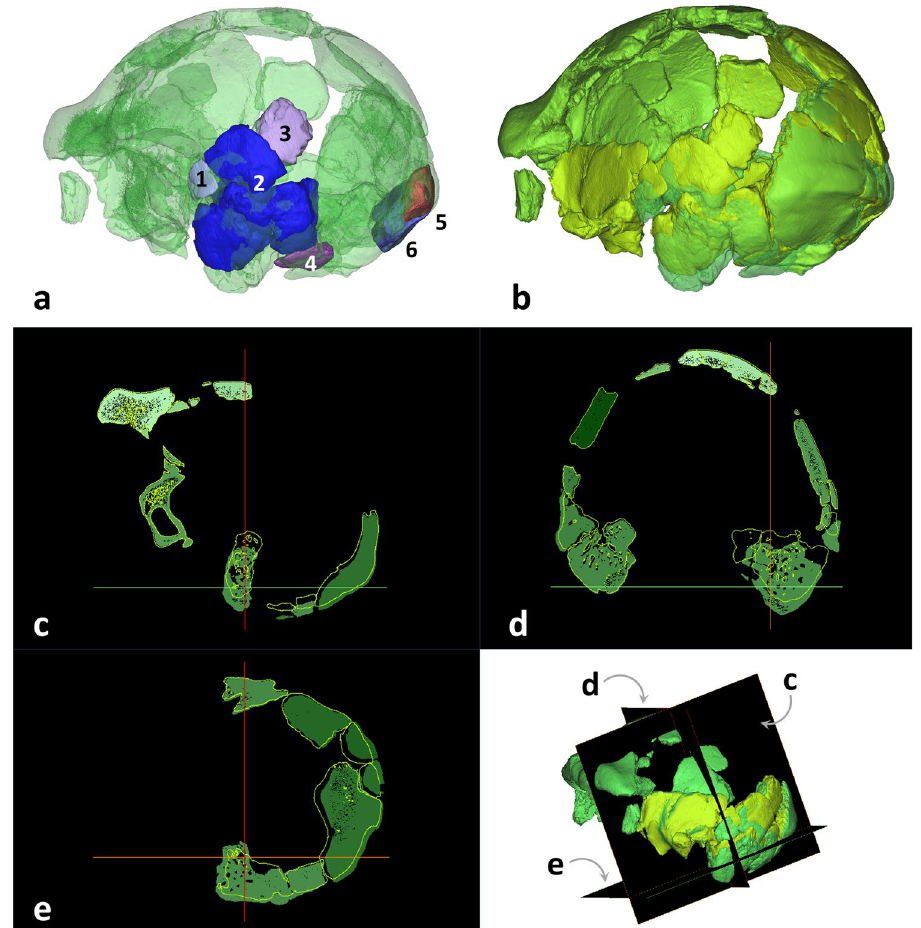
Figure 4. These pictures show changes occurred in our digital reconstruction of the Ceprano calvarium with respect to the last physical one 3 . ( a ) Temporal fragments labeled 1-4 are moved superiorly and rotated anteriorly and connect better with other portions of the left temporal bone; while the occipital fragments 5 and 6 are moved slightly medially to fit better with the occipital bone (compare Figure S6). ( b ) The final result is represented in light green (dark green = former reconstruction). ( c–e ) Three orthogonal sections showing the main differences in the position of the bony fragments 1–4 when moved from the previous reconstruction (solid surfaces) to the newly restored one (empty light